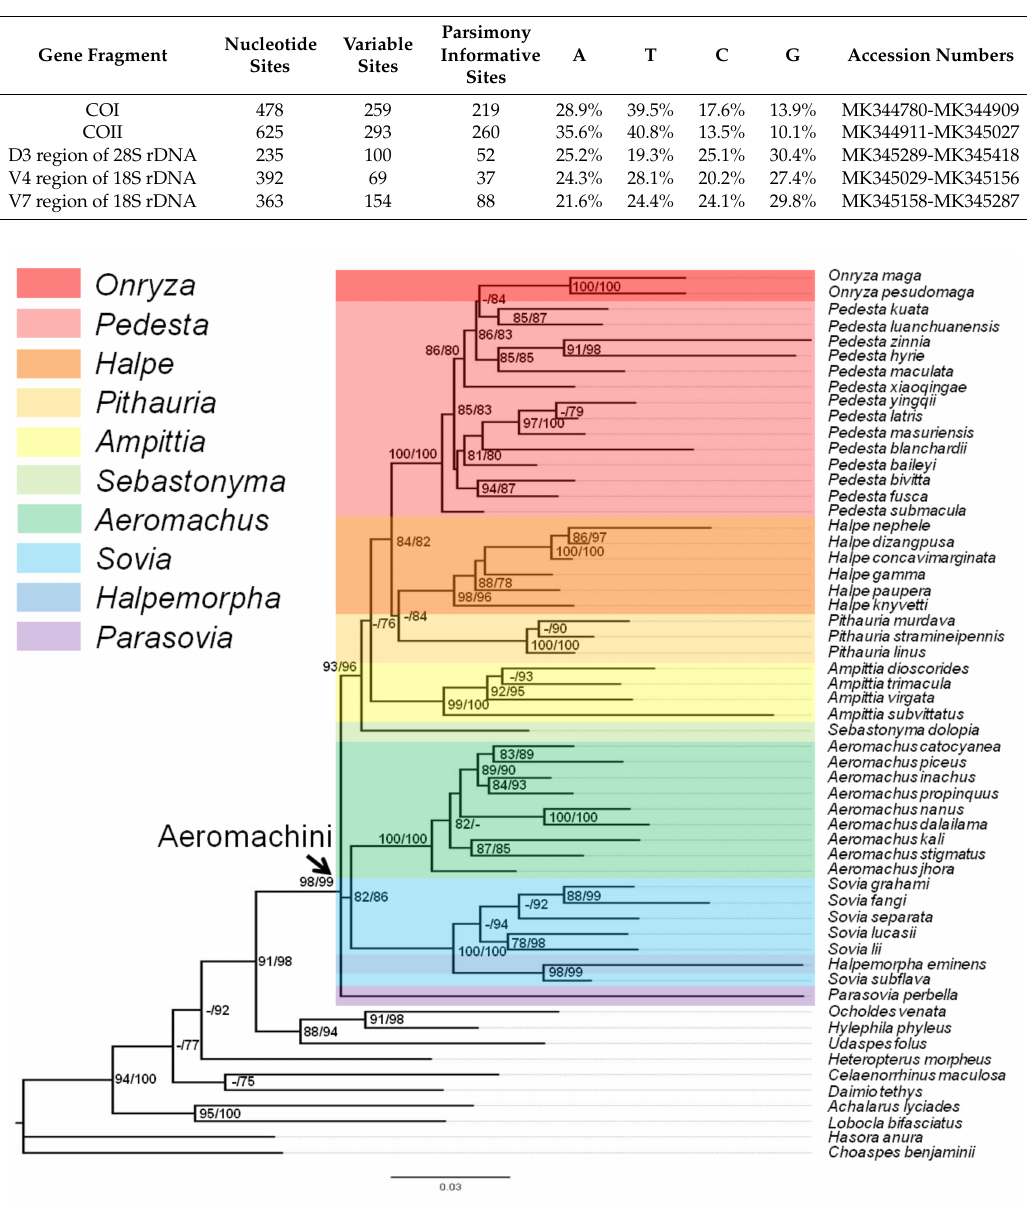
Figure 2. Maximum-likelihood phylogeny of Aeromachini sampled for this study. The phylogeny is inferred by IQTREE based on concatenated mitochondrial and nuclear genes (totaling 2084 bp). Numbers beside nodes are IQTREE ultrafast bootstrap and SH-aLRT values. The species from the ten genera are marked in di ff erent